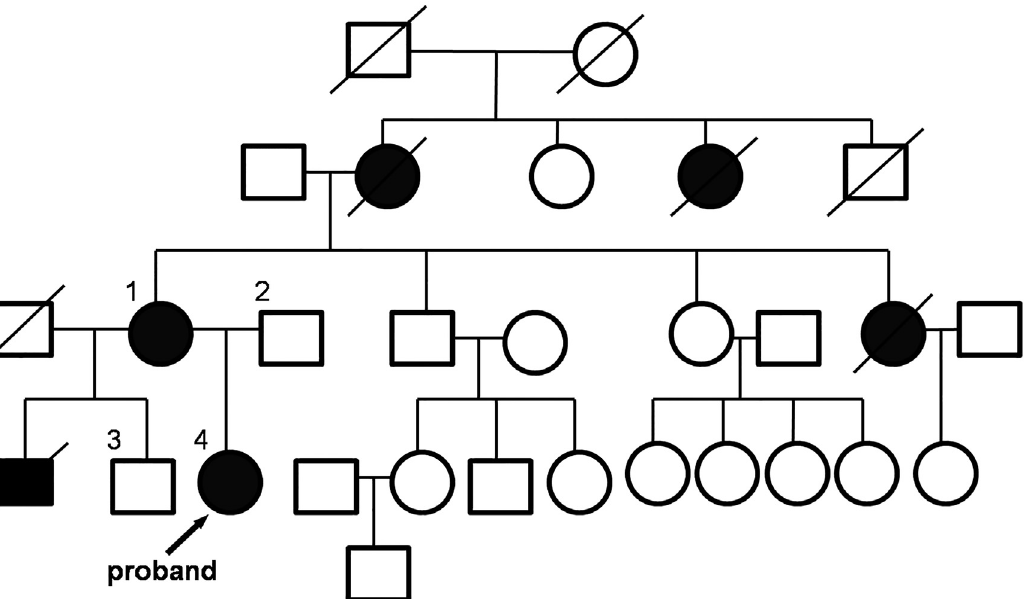
Fig 1. Pedigree of a Kazakh Family with X-Linked Alport Syndrome. Affected individuals with kidney disease are shown with blackened squares (males) and circles (females). Normal individuals are shown with empty squares (males) and circles (females). Crossed squares or circles denote deceased individuals.